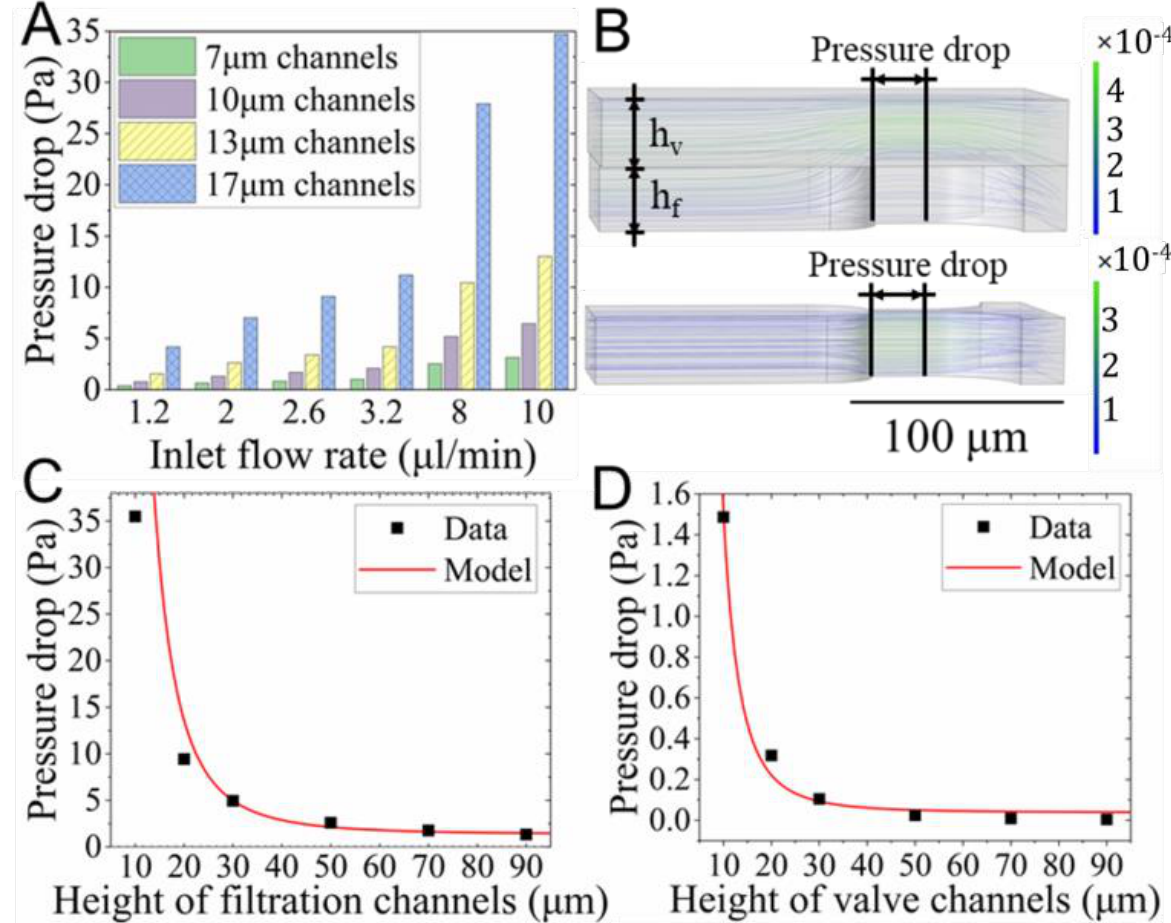
Figure 2. Numerical studies of the flow field. ( A ) The pressure drop across the four-level filtration channels with widths of 7 − 17 µ m at various flow rates. ( B ) The streamlines in models containing a 13 µ m wide filtration channel with ( top ) or without ( bottom ) the valve channel at the flow rate of 2.6 µ L/min. The h v and h f refer to the height of the valve channels and the filtration channels, respectively. The pressure drop at the flow rate of 2.6 µ L/min when the height of ( C ) the filtration and ( D ) the valve channels varied.